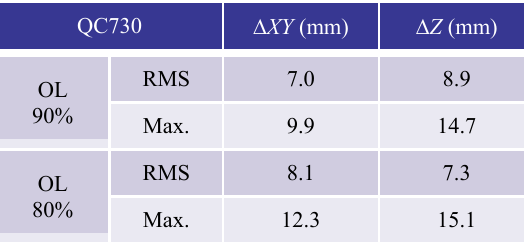
Table 4. Measurement errors of 9 check points by QC730 vs. overlapping ratio OL